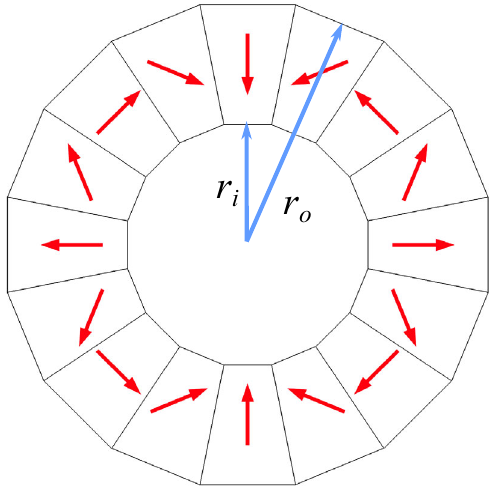
FIG. 10. A schematic arrangement of magnetic blocks and easy-axis direction of a 16-segment PMQ.